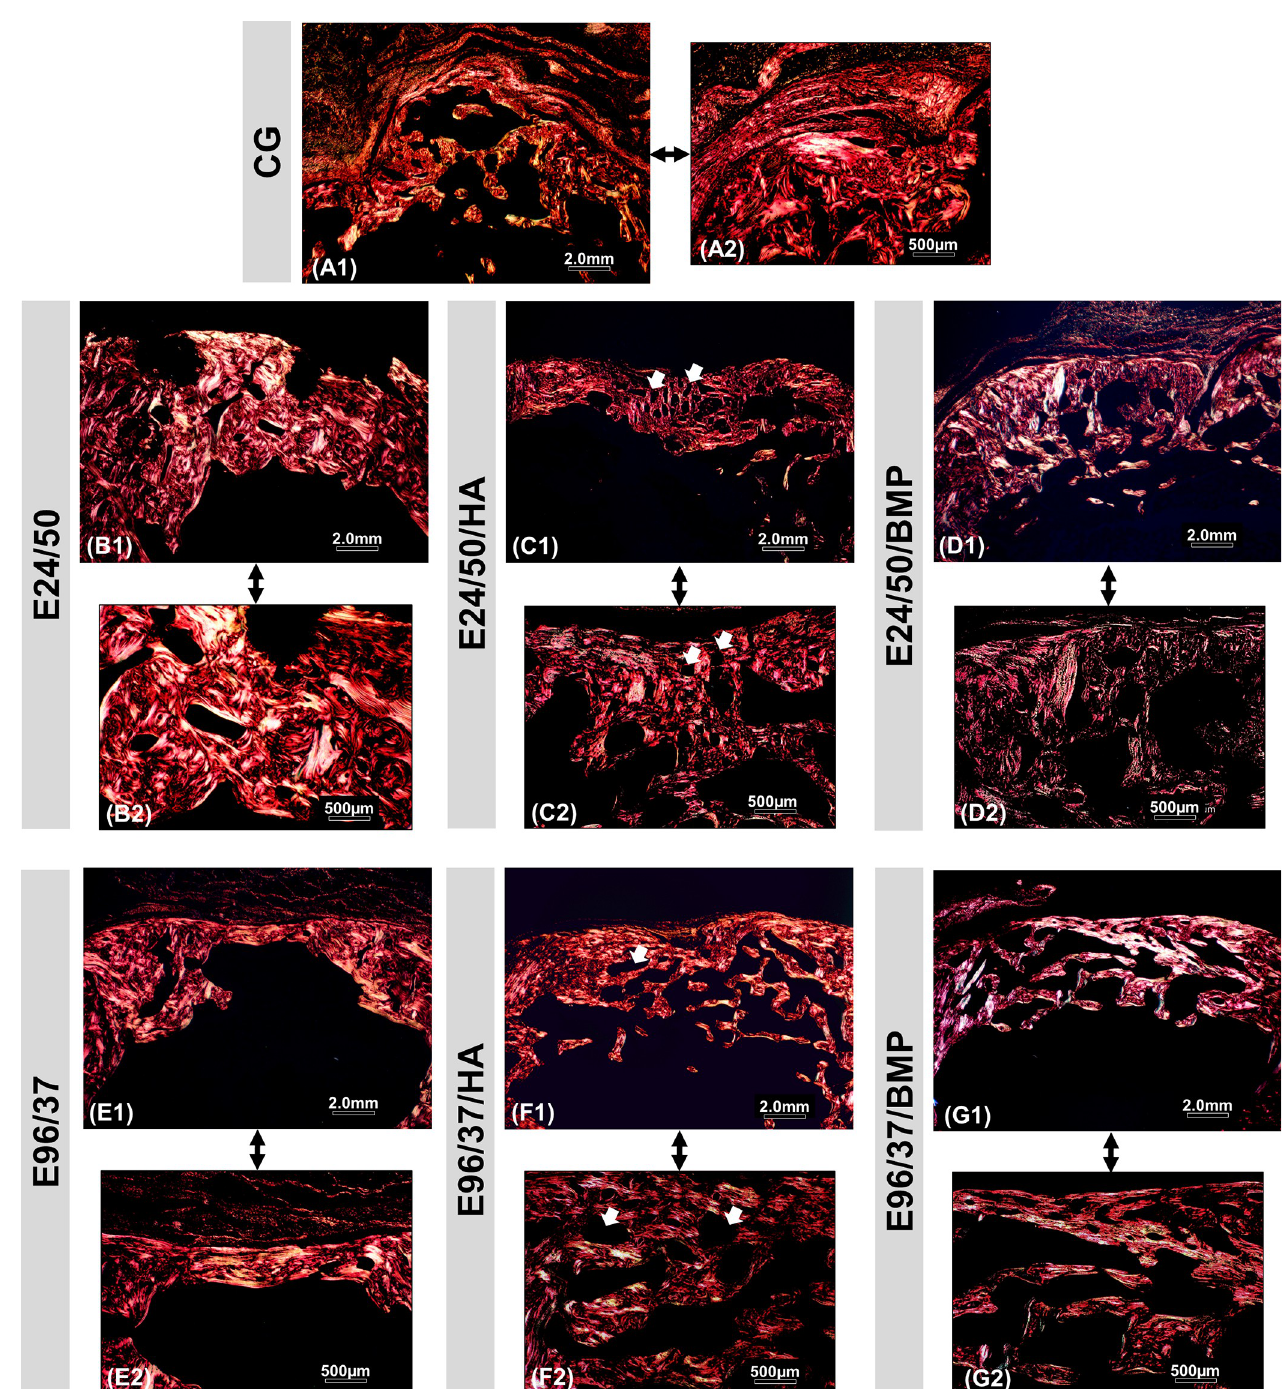
Fig 8. Images of birefringent collagen fibers by PSR-polarization method in the area of bone defect created in the distal femoral metaphysis in rats. Picrosirius red (PSR) stained collagen fibers are specifically birefringent in polarized light, fine green/type III fibers; thick red fibers/type I. Red-orange birefringence was observed predominantly in all experimental groups at 42 days, corresponding to thicker and more organized collagen fibers. Note the similarity between the birefringence of the remaining collagen fibers of the newly formed tissue. Hydroxyapatite particle (white arrow). Original 4x magnification: (A1-G1) Bar: 2 mm. Inset10x magnified images (A2-G2) Bar: 500 μ m.